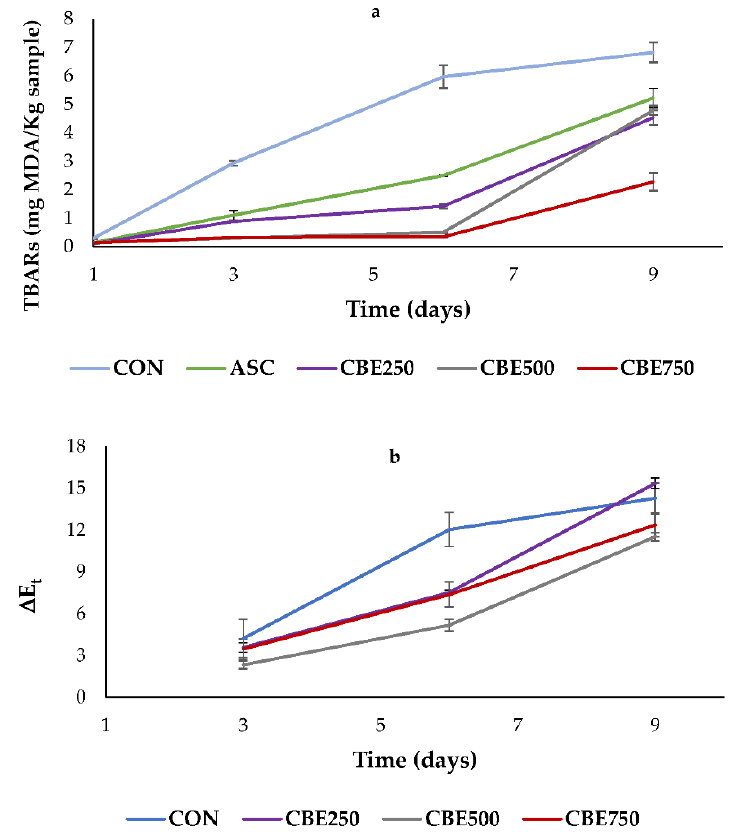
Figure 2. ( a ) TBARS and ( b ) Δ E t values of pork patties during refrigerated storage. Pork patties without antioxidant (CON), treated with ascorbic acid (ASC), and treated with different levels of Colombian berry extract (CBE) (CBE250: 250 ppm; CBE500: 500 ppm; CBE750: 750 ppm).